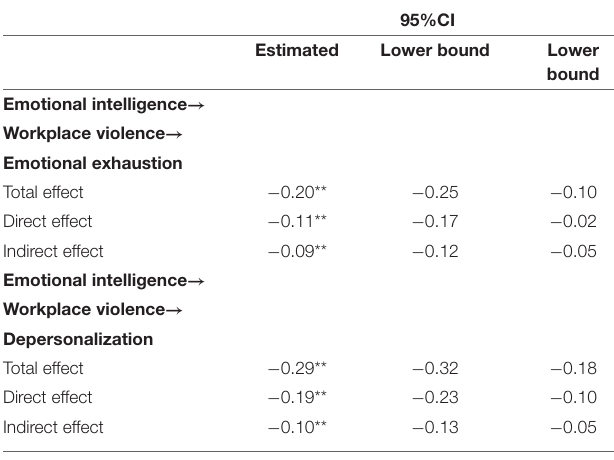
TABLE 4 | Direct and indirect effects and 95% confidence intervals for the final